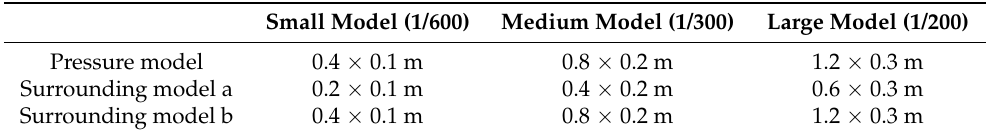
Table 1. The geometry size of the test models.